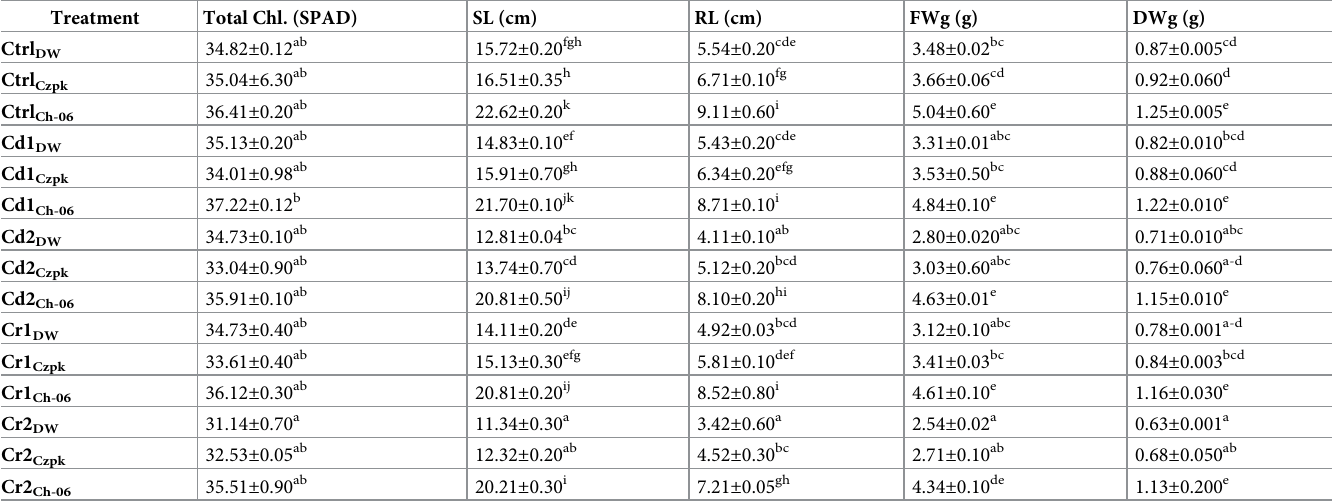
Ctrl = control, Cd = cadmium, Cr = chromium, Cd1 and Cr1 = 100 μ g/g, Cd2 and Cr2 = 500 μ g/g, DW = distilled water, Czpk = Czapek broth, SL = shoot length, RL = root length, FWg = plant fresh weight, DWg = plant dry weight. The data reflect the mean of triplicated data followed by ± SE. The data with different superscript letter are significantly different at P =